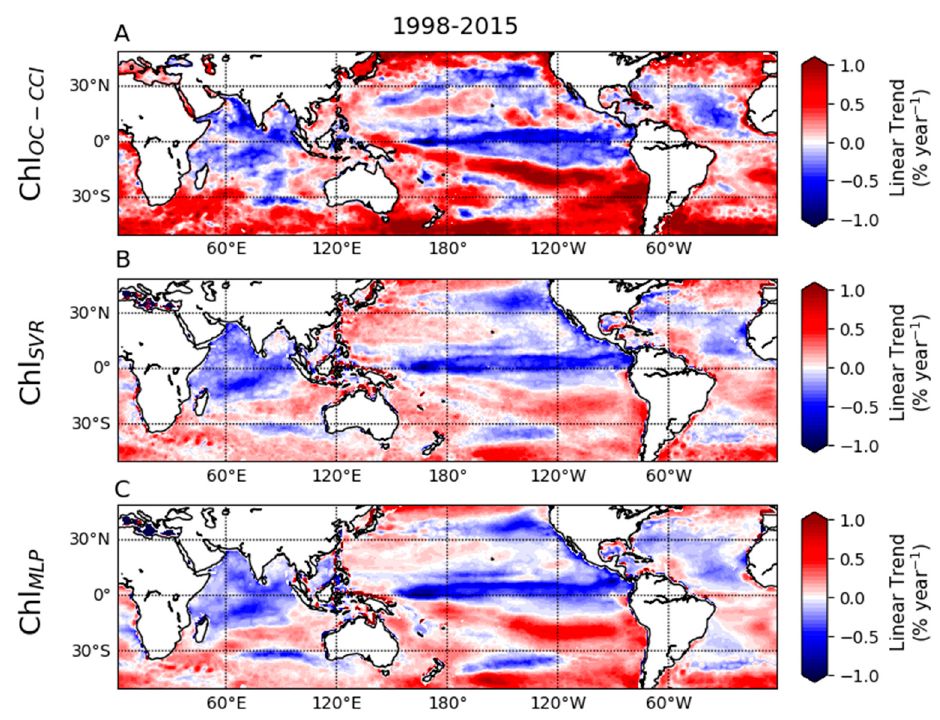
Figure 5. Linear log of (Chl) trend (in % year − 1 ) calculated over 1998–2015 from the monthly ( A ) Chl OC-CCI , ( B ) Chl SVR , ( C ) Chl MLP